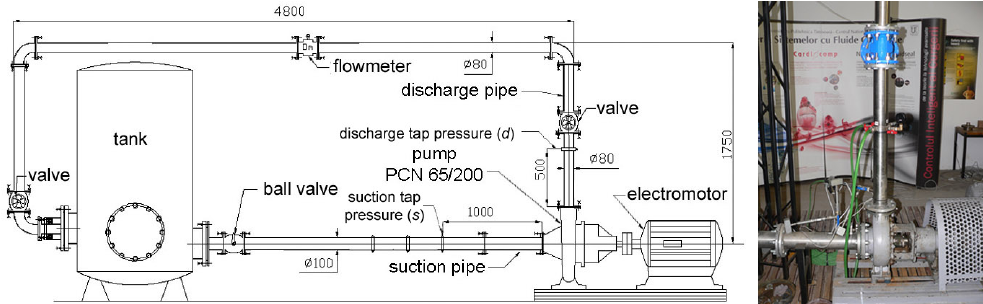
Figure 4. The test rig available at the Hydraulic Machinery Laboratory of the “Politehnica” University Timi¸soara. Schematic view of the test rig with actual dimensions in mm and